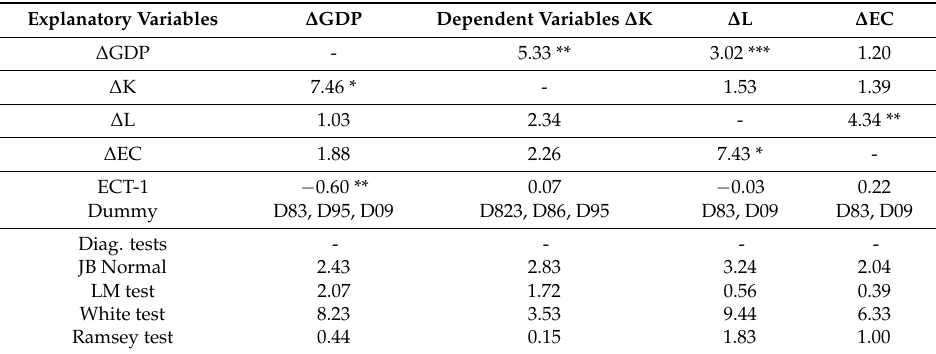
Table 6. Granger causality test results: Aggregated